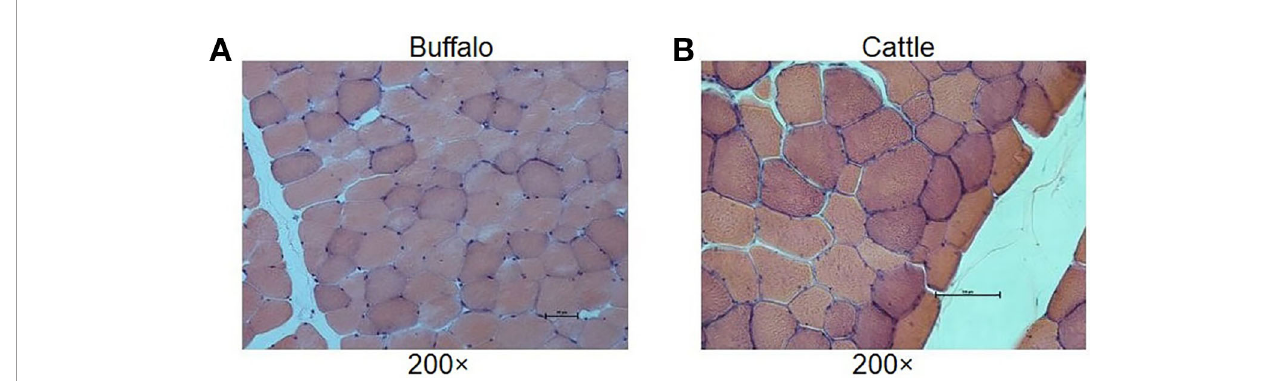
FIGURE 1 | Histological analysis of longissimus dorsi muscles. The HE staining of muscle results showed that the muscle fi ber area, isometric diameter, circumference and density of buffalo (A) were signi fi cantly smaller than those of cattle (B) .